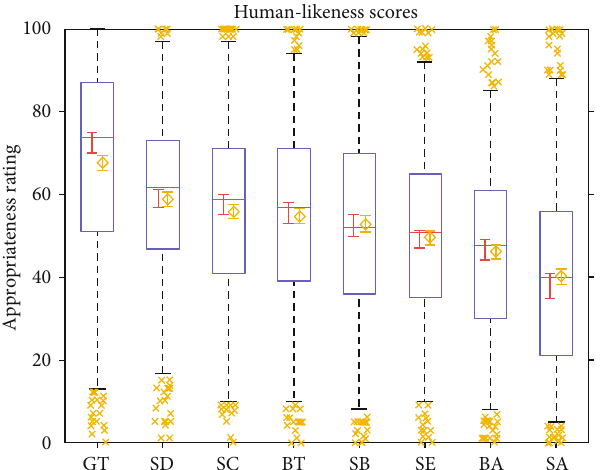
Figure 2: Human-likeness scores to every gesture synthesis systems. Here, the red line segment is the con fi dence intervals, Red line is the median value, yellow x represents outiler symbol, and yellow line in the rectangle is the mean value, and SA to SE are 5 di ff erent generation system, GT represents grand truth, BA and BT represent system with only audio and system with only text.